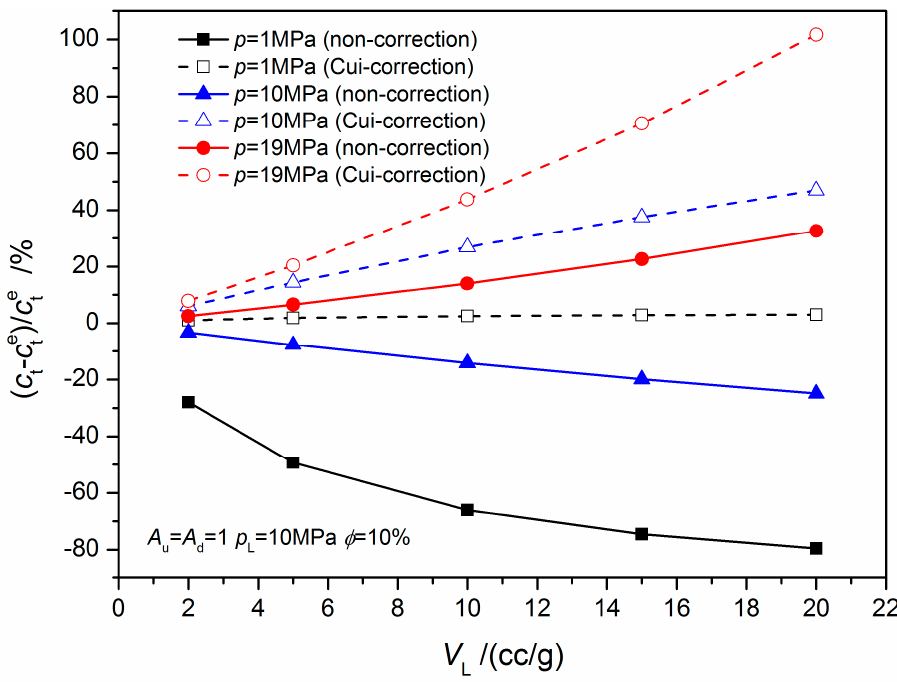
L on the total compressibility. Energies 2019 , 12 , x FOR PEER REVIEW